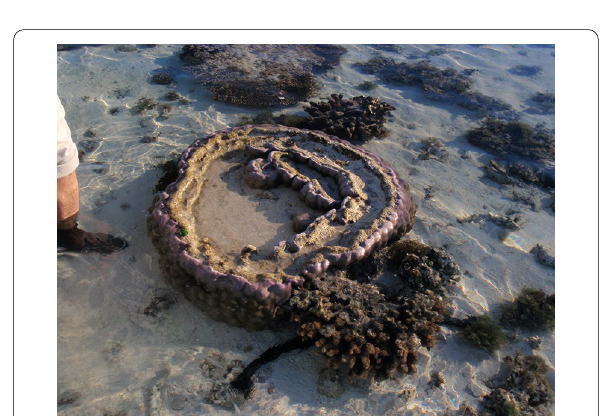
Fig. 5 Living microatoll in the Great Barrier Reef, Australia (Yokoyama and Esat